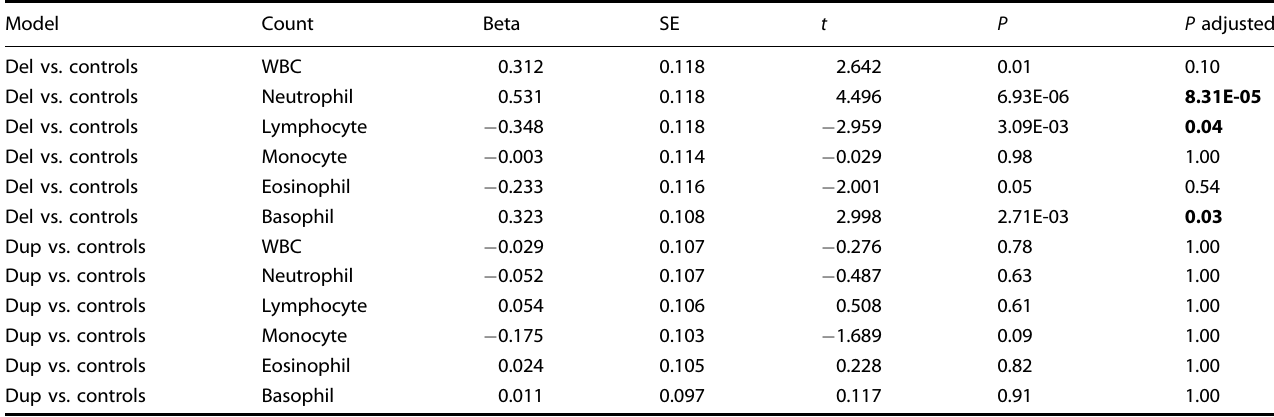
Table 3. White blood cell differential counts in 16p11.2 CNV carriers from the UK biobank and comparison with controls. Model Count Beta